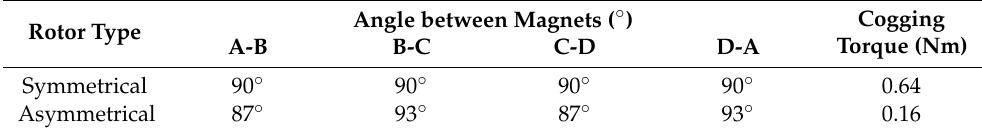
Figure 11. Compared Rotor structure ( a ) Symmetrical rotor structure with an angle difference of 90 ◦ ; ( b ) asymmetrical rotor structure with 3 ◦ magnet shifting. Table 6. Comparison of cogging torque for the symmetrical and the asymmetrical